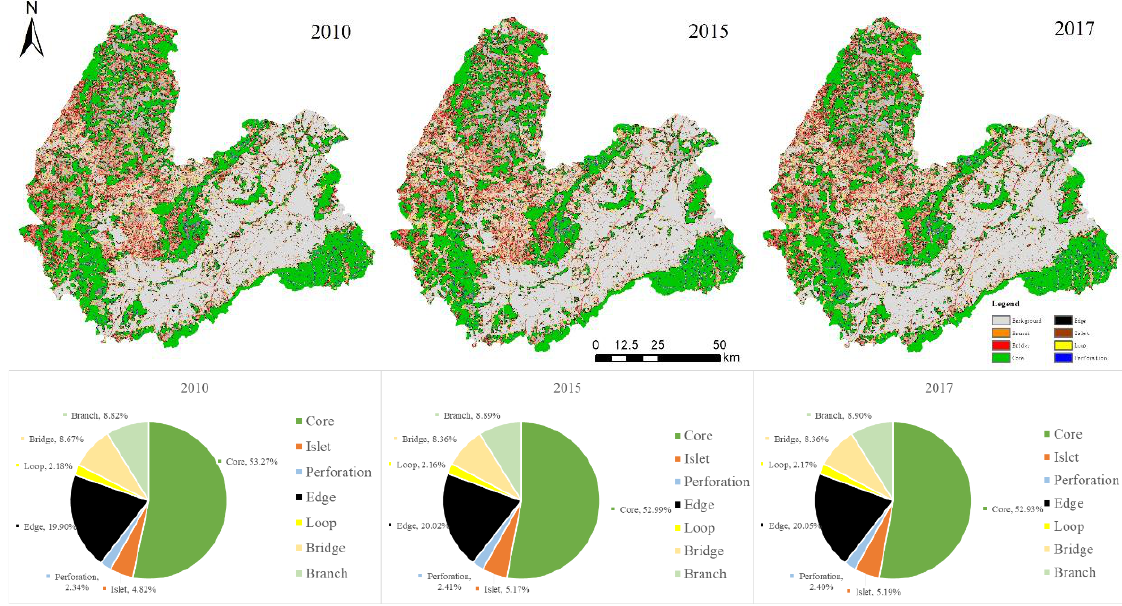
Figure 5. Distribution and proportion of pattern classes based on MSPA.